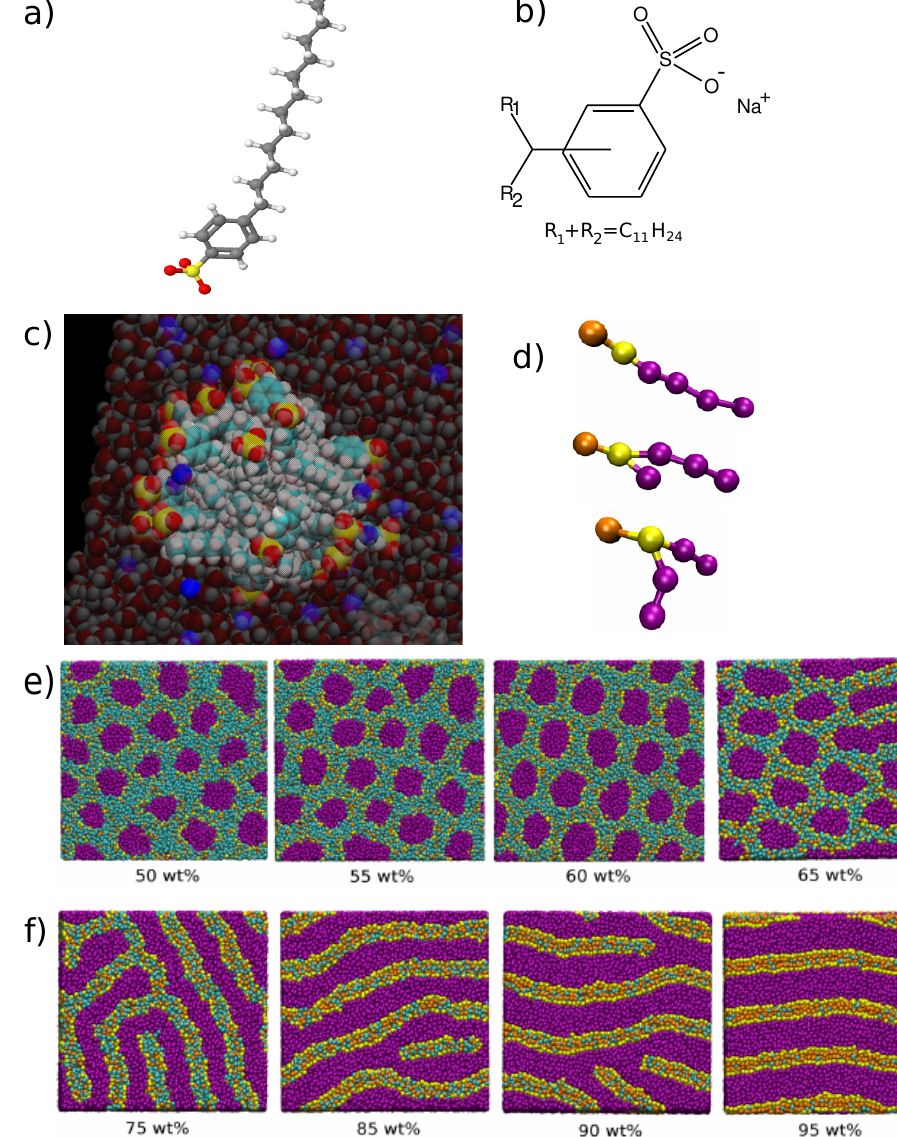
Figure 6. Structures and simulation models for versions of LAS (linear alkylbenzene sulfonates). ( a ) Molecular structure of a fully linear single chained version of the anionic surfactant LAS; ( b ) chem- ical structure of typical branched LAS molecules used in industry, ( c ) single micelle of LAS in water (sulfonate head groups are shown in yellow and red, and blue sites represent sodium counter ions, water molecules are shown in a partially transparent representation); ( d ) three DPD models of LAS with the orange bead representing the sulfonate head group, the yellow bead representing the phenyl group, and the purple beads representing parts of the alkyl chain; ( e , f ) simulations snapshots from the phase diagram of the linear form of LAS adapted with permission from Ref. [91], 2018, Sarah J. Gray; showing ( e ) the hexagonal phase composed of cylindrical micelles and ( f ) the lamellar